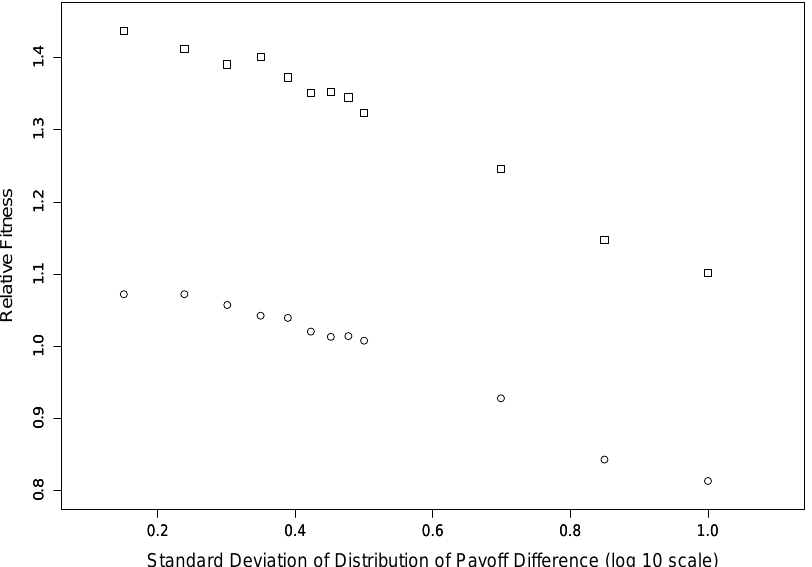
Figure 1. The effect of quality of the environmental cue on relative fitness gain associated with payoff bias. The squares represent cases where the quality of the environmental cue is low ( ξ = 0.01) and the circles the cases where it is high ( ξ = 0.1). The x-axis represents the quality of the payoff information, √ v on a log10 scale. Other parameters are as follow: n = 3, γ = i.e.,